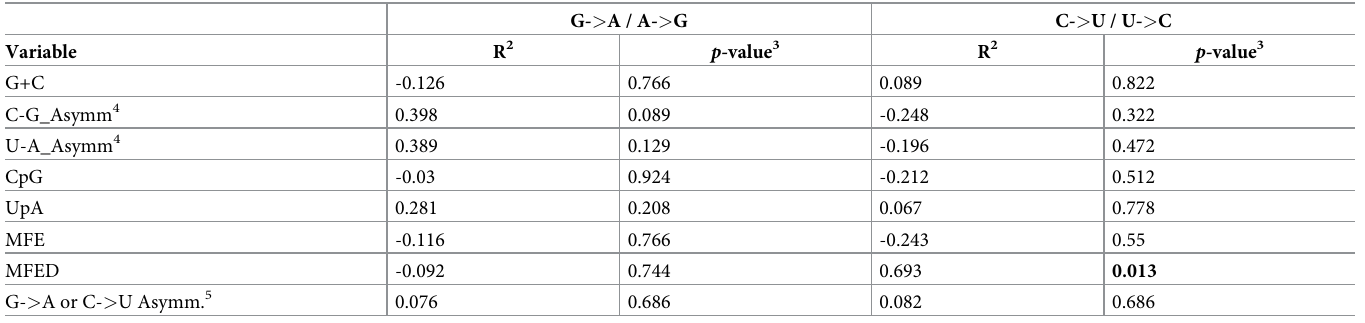
G- > A or C- > U Asymm.